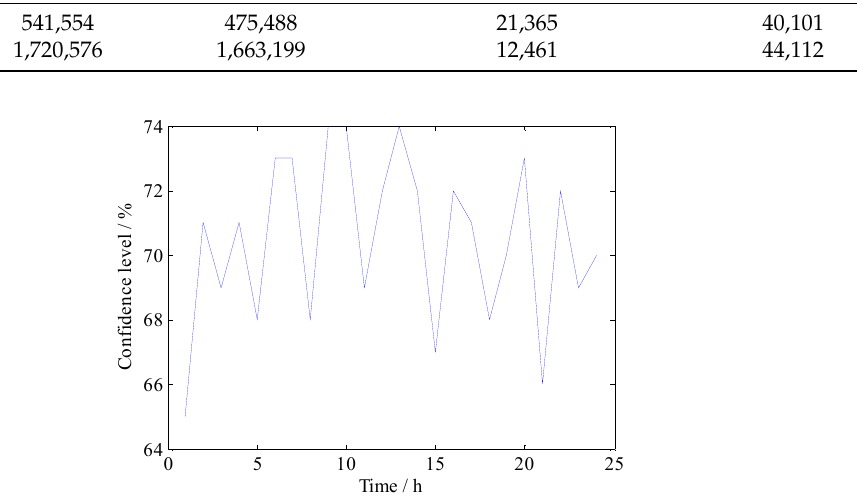
Table 4. The costs for Case 3 and Case 4.